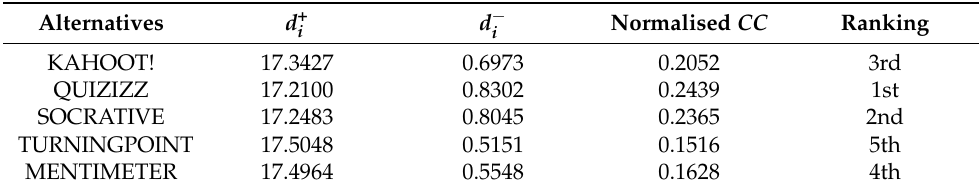
Table 9. The distances, normalised closeness coefficient, and ranking of alternatives in the case of W S = 0.5 and W O = 0.5, using objective weights from fuzzy Shannon entropy.